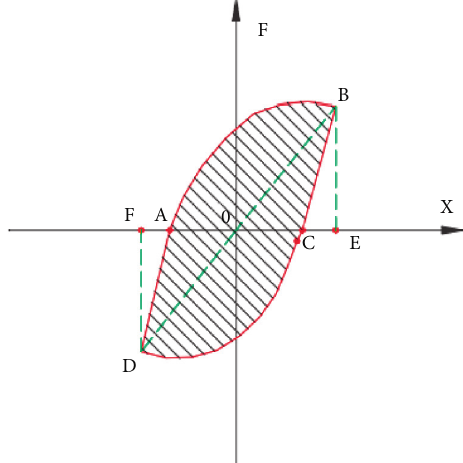
Figure 15: Load-deformation hysteresis curve.